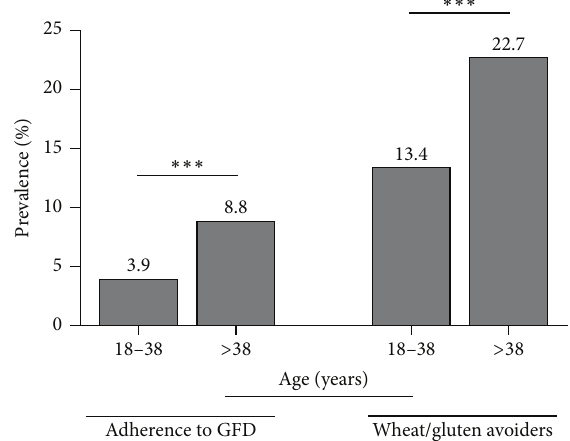
Figure 2: Prevalence of adherence to a GFD and wheat/gluten avoidance stratified by age (years). ∗∗∗ 𝑝 < 0.001